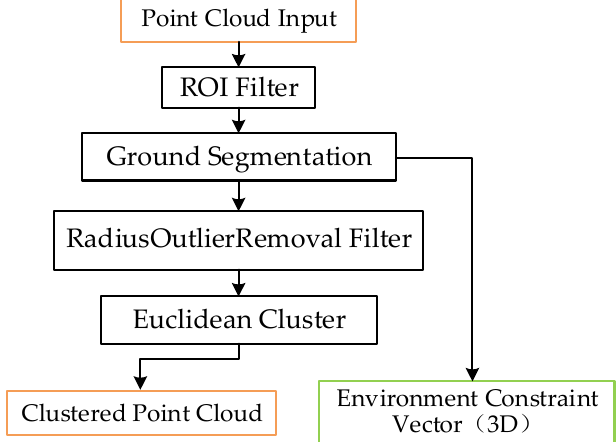
Figure 2. Adopted preprocess and segmentation method.